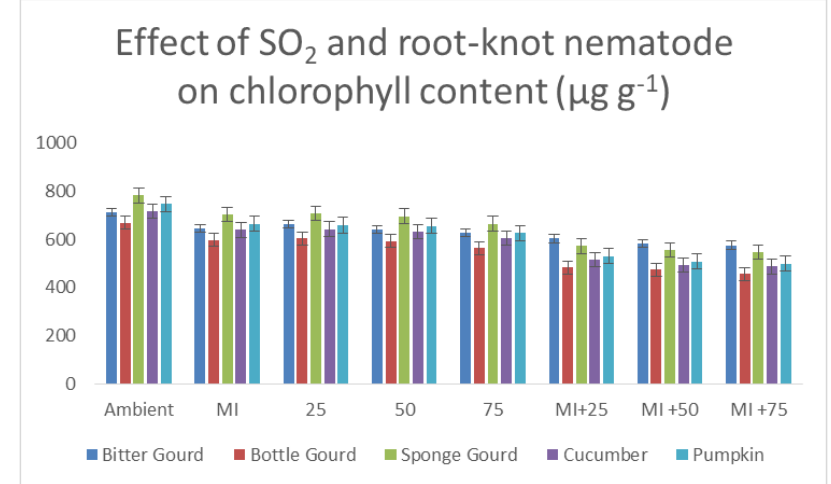
Figure 9. Bar diagram showing the effect of SO 2 exposure and root-knot nematode inoculation on the total chlorophyll content of leaves of five cucurbits.